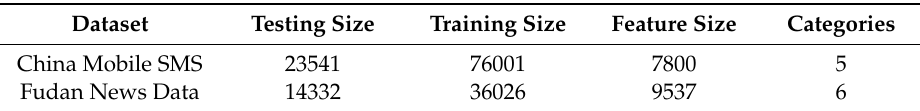
Table 3. Dataset and feature size.